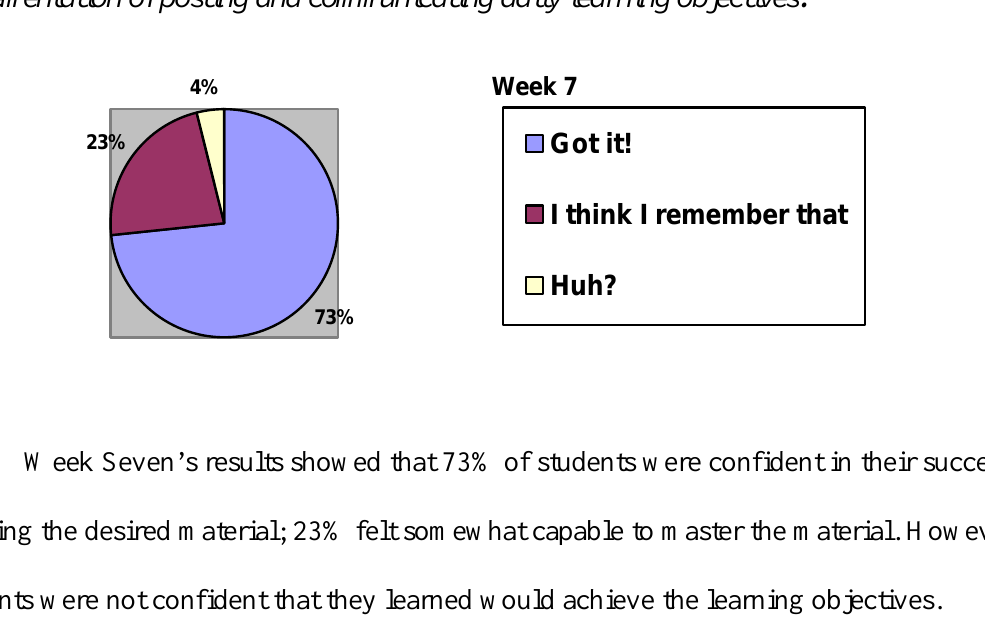
Figure 12. Student Comprehension Checklist compiled during the seventh week of the implementation of posting and communicating daily learning objectives.